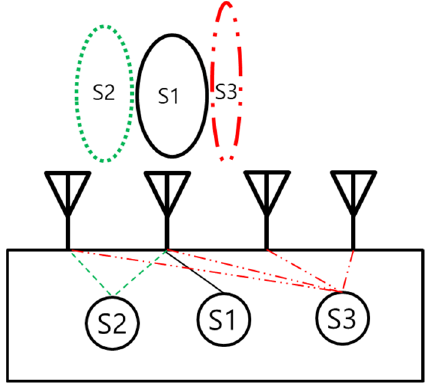
Figure 1. Beam pattern according to switch